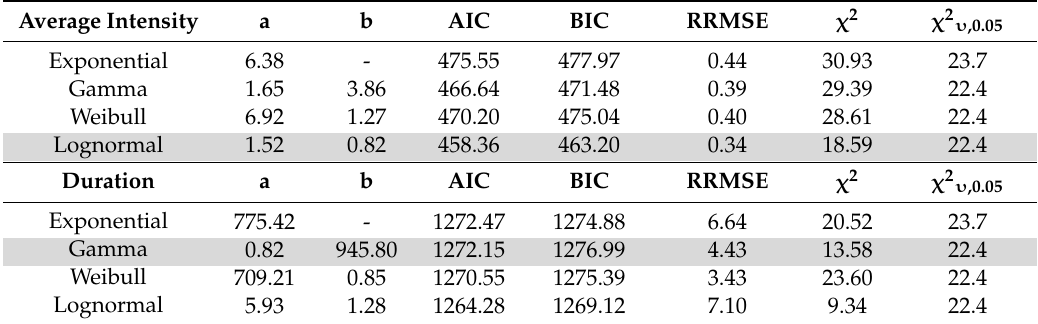
Table 4. Marginal distribution parameters and goodness of fit results—Palazzolo Acreide rain gauge